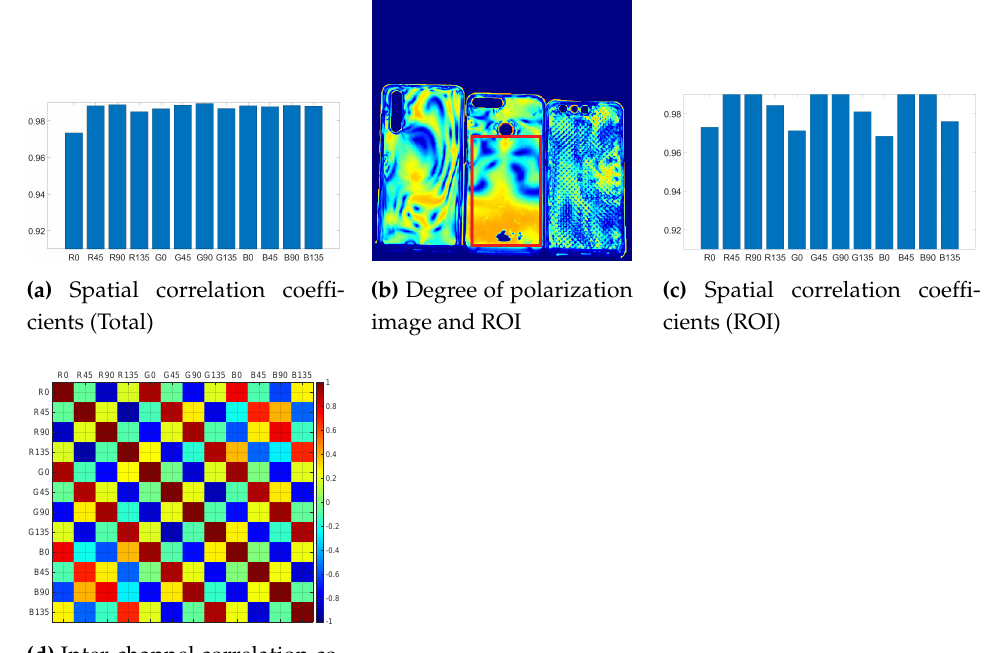
Figure 6. ( a ) Spatial correlation coefficients computed for all of the observations. ( c ) Spatial correlation coefficient computed from an active polarization scene (“cellphonecases” scene in Figure 2h), where the Region Of Interest (ROI) selected is surrounded in red in ( b ). ( d ) Inter-channel correlation computed for the